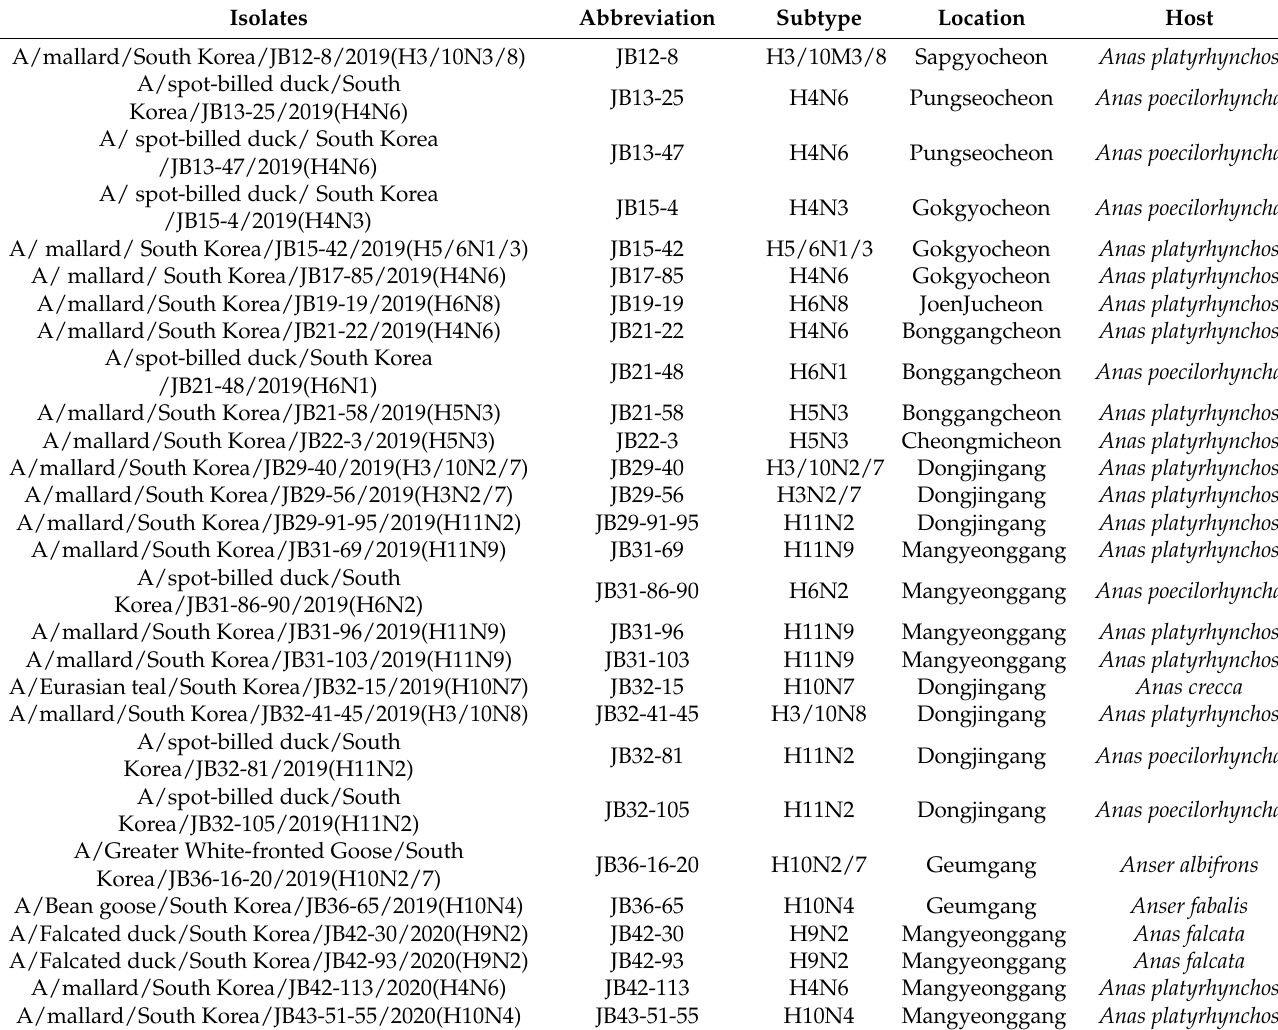
Table 2. Avian influenza viruses (AIVs) isolated from wild birds in South Korea between 2019 and 2020.